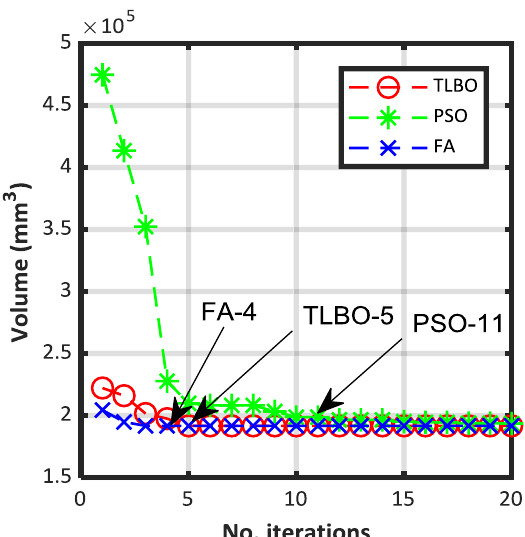
Fig. 8. Hub-hole pro fi le convergence results.